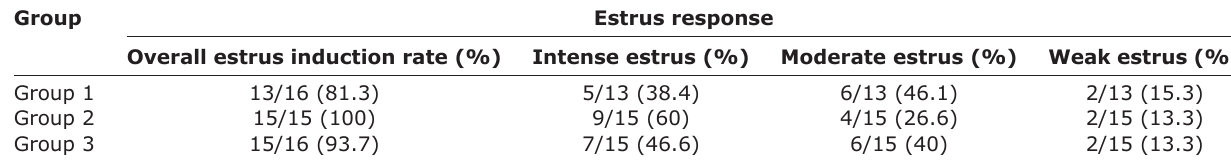
Table-2: Estrus response depending on intensity of heat symptoms following different estrus induction protocols in buffaloes. Group Estrus